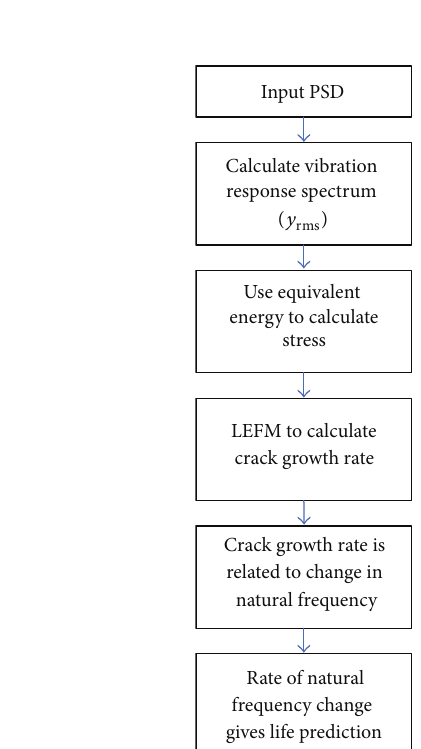
Figure 9: Virtual crack extension.